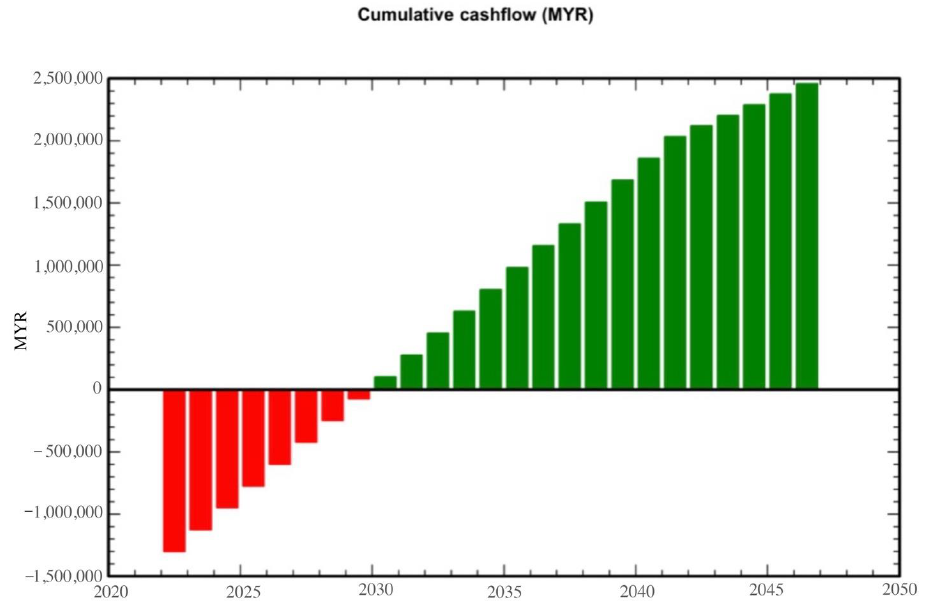
Figure 5. Cumulative cashflow in MYR during the lifetime of 380 kW PV system.